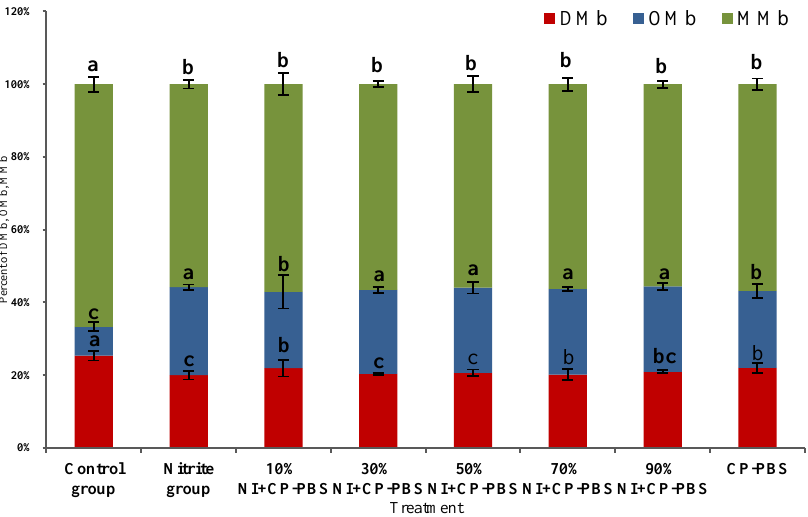
Figure 1. Effect of different treatments on the relative contents of the three myoglobins in smoked sausage. a~c Different letters indicated significant differences among the treatment groups at p <0.05.